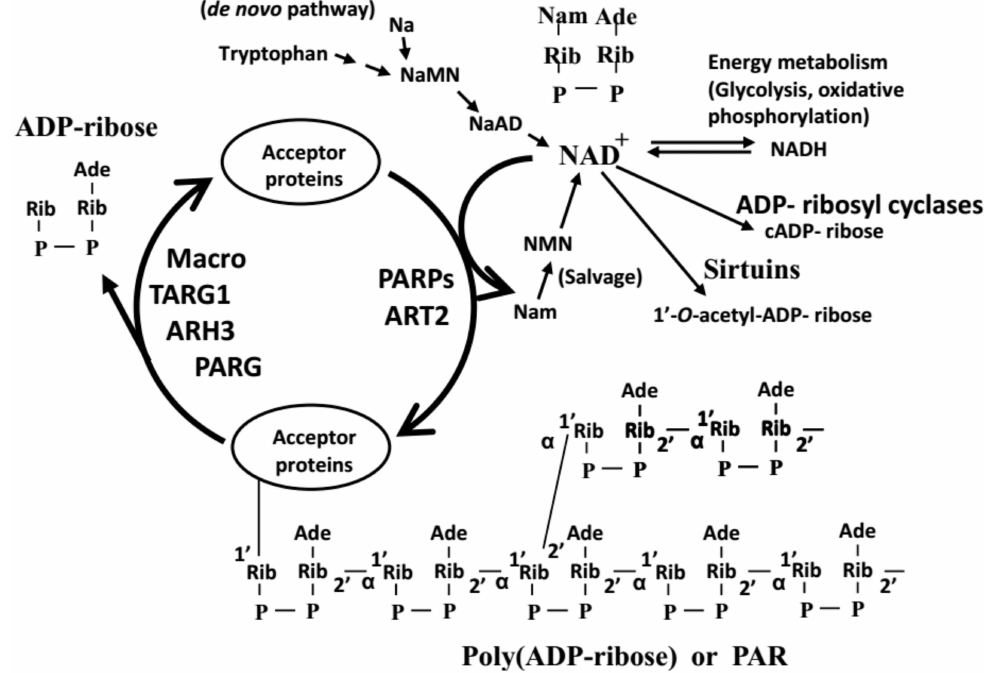
Figure 1. PolyADP-ribosylation reaction. ARH3: ADP-ribosylhydrolase 3; ART2: ADP-ribosyltransferase